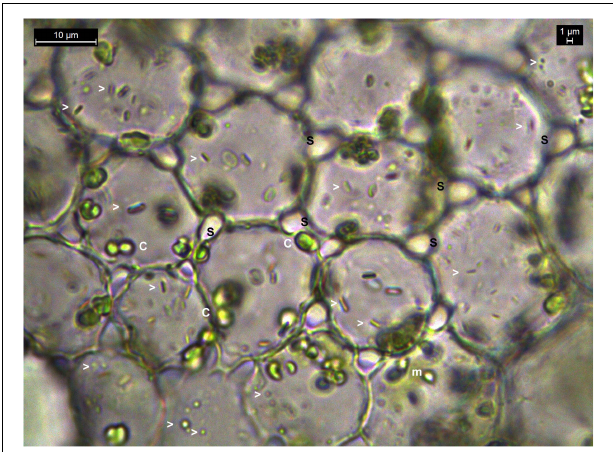
FIGURE 1 | Bright-field microscopy on thin tissue section of water lettuce petiole (1000 × ). Tissue section showing abundant bacteria in the intracellular region. Arrowheads indicate bacterial cells; c, chloroplasts; m, mitochondria; s, inter-space between cells where no bacteria are